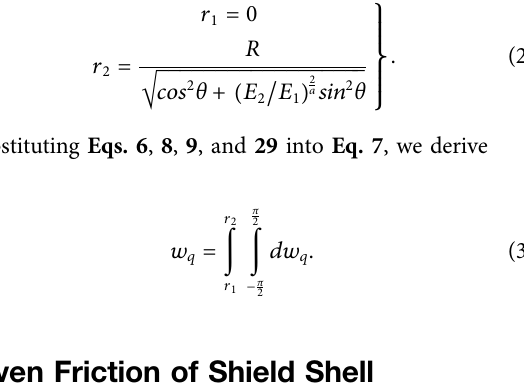
between the shield shell and surrounding soil is shown in Figure 4 . The calculation model can be regarded as the horizontal load acting along the cylinder axis on the side surface of the cylinder. The friction force f is assumed to be unevenly distributed along the central axis. For f 1 and f 2 , the tunneling soil layer is divided into upper and lower layers. The inner and outer thrusts of the curve are q 1 and q 2 , respectively. to the tail of the shield is L. Then, the area of any in fi nite element on the surface of the shell is given by dA = Rd θ dl , where l is the axial distance from the in fi nite element to the excavation surface, and the concentrated force received is dP h = fR ′ d θ dl . We substitute l = − l, m = R ′ cos θ , and n = 0 in Eq. 6 to transform the coordinate system as